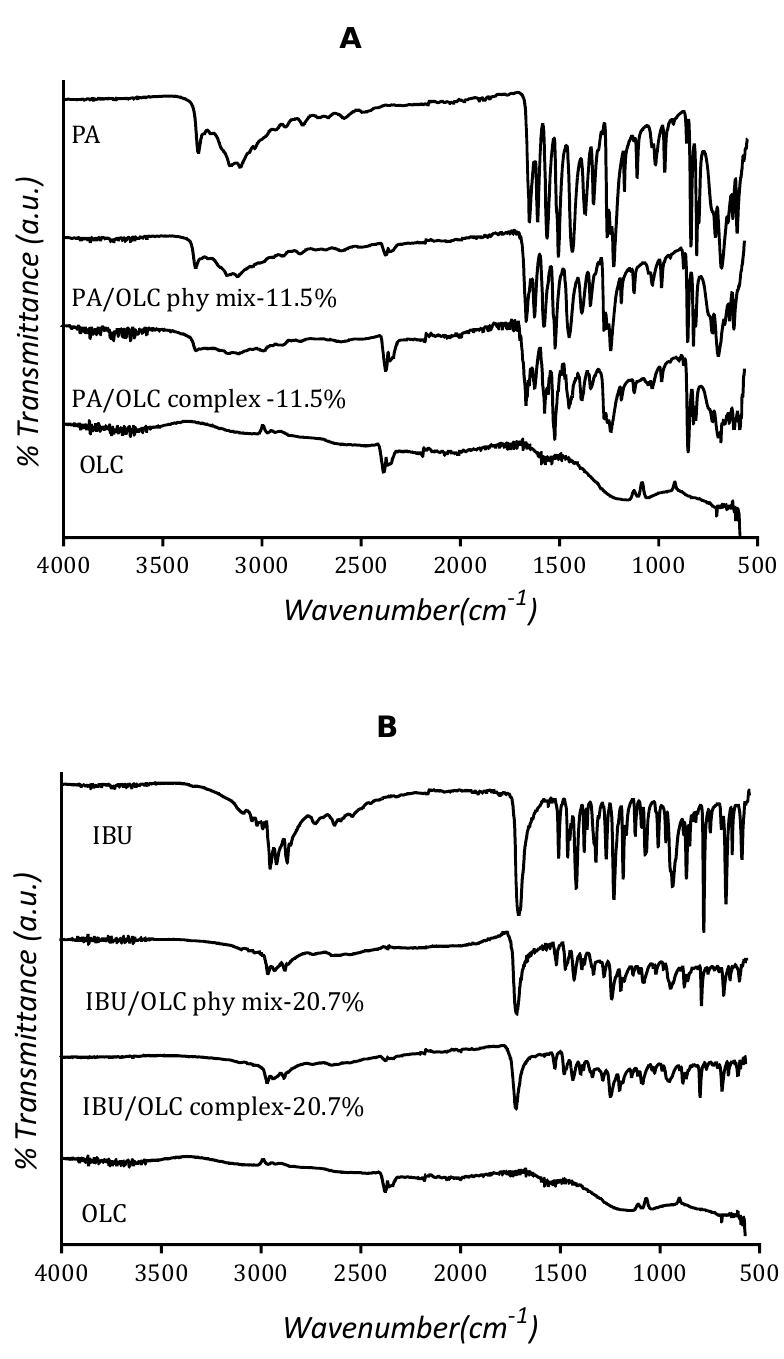
Figure 6. ( A ): FTIR spectra of paracetamol (PA), carbon onion (OLC), paracetamol-loaded carbon onion (PA/OLC complex) and physical mixture of paracetamol and carbon onion (PA/OLC phy mix). ( B ): FTIR spectra of ibuprofen (IBU), carbon onion (OLC), ibuprofen-loaded carbon onion (IBU/OLC complex) and physical mixture of ibuprofen and carbon onion (IBU/OLC phy mix). Note that the transmittance scale is arbitrary.